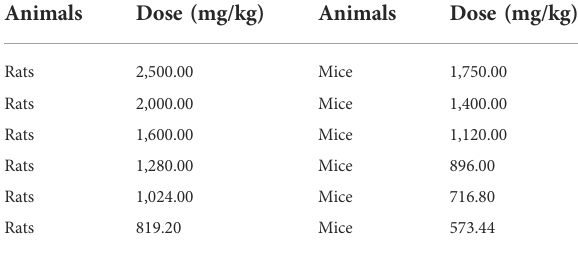
TABLE 1 Oral acute toxicity dosing regimens in rats and